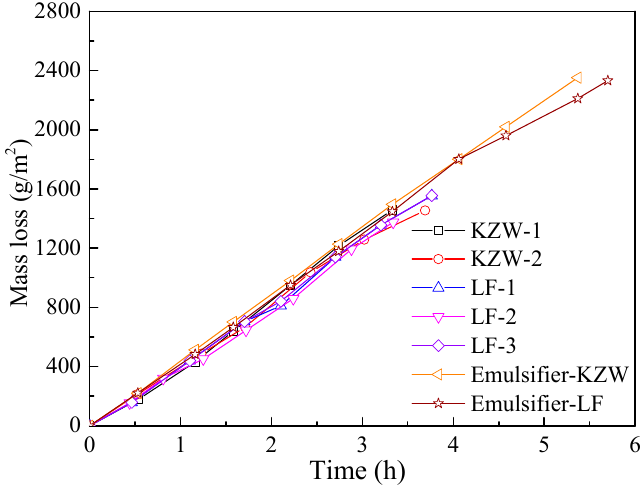
Figure 8. The first drying stage of emulsions and their emulsifier solutions. Emulsifier not only cannot affect the initial evaporation rate of bitumen emulsion, but also cannot affect its drying parameters of φ 1 , φ m and φ 2 . It can be seen from Table 4 that KZW-1 and LF-1 can have high values of φ 1 , φ m and φ 2 , but parameters of φ 1 , φ m and φ 2 are relatively low for KZW-2, LF-2 and LF-3. Therefore, emulsions produced by both emulsifiers may be of good or bad quality in drying. Overall, the drying behavior of bitumen emulsion is independent on the emulsifier